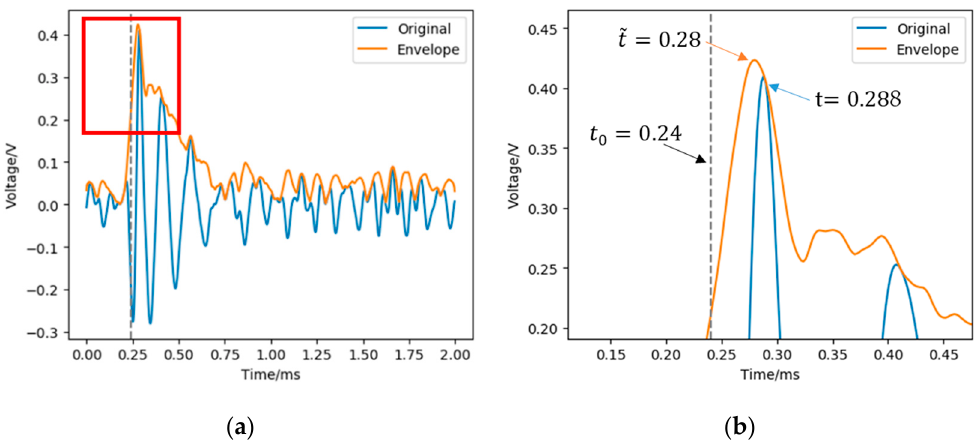
Figure 5. ( a ) Lightning signal in the VLF band and Hilbert envelope. ( b ) The enlarged view near the peak point of ( a ). The dotted line indicates the trigger moment.